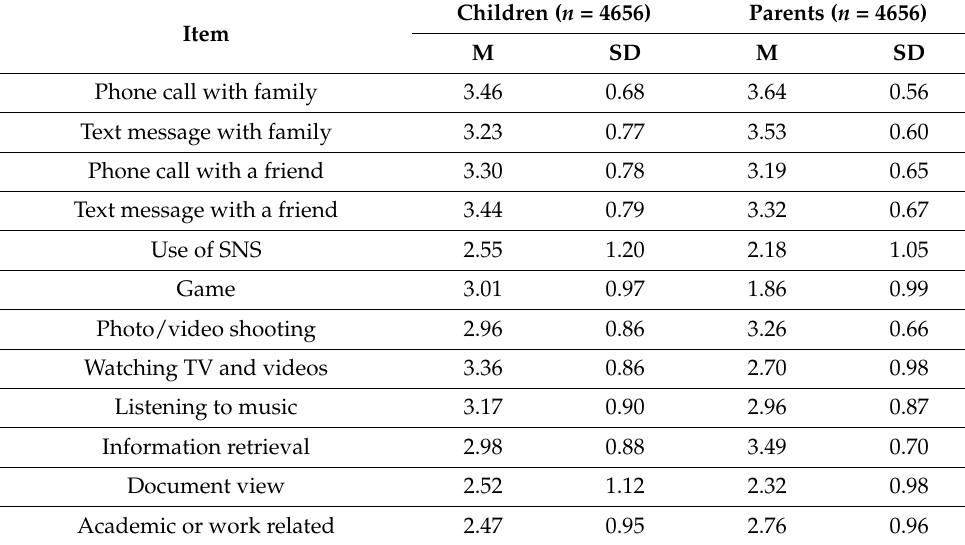
Table 2. Level of smartphone usage by children and parents by purpose.